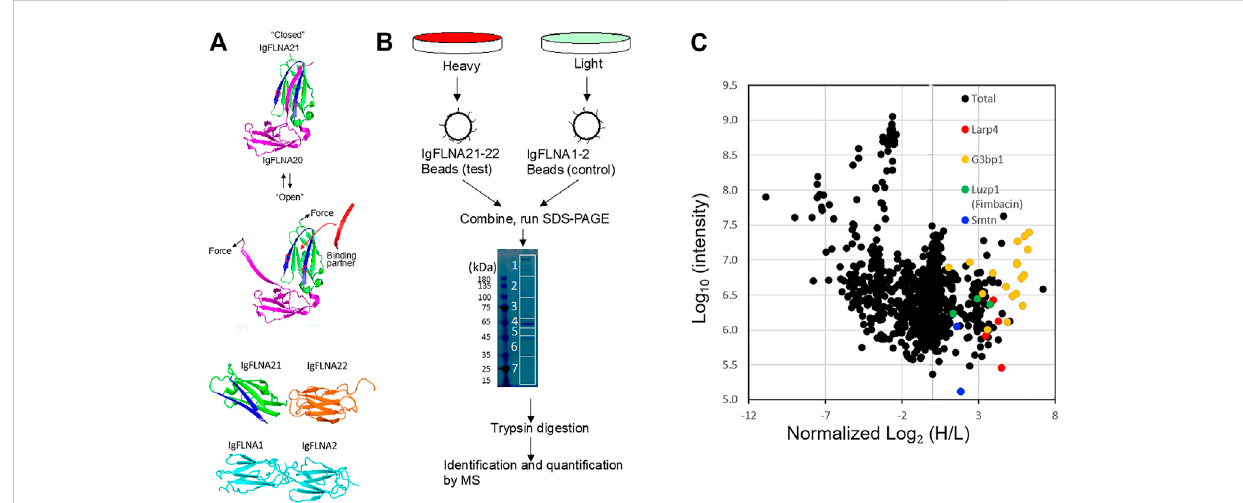
FIGURE 1 SILAC-based proteomics of FLNA-binding partner. (A) The CD cleft (blue) opens for partner interaction in force-dependent manner. FLNA domains usedfor af fi nitypuri fi cation ofmechanically-regulated FLNA-binding partner.IgFLNA1-2 was usedas anegativecontrol. (B) Schematic representation of the SILAC-based mass spectrometry experiments. (C) Standard scatterplots with normalized Log 2 (H/L) ratios/Log 10 Intensities (control versus test) highlighting the distribution of quanti fi ed proteins in each MS